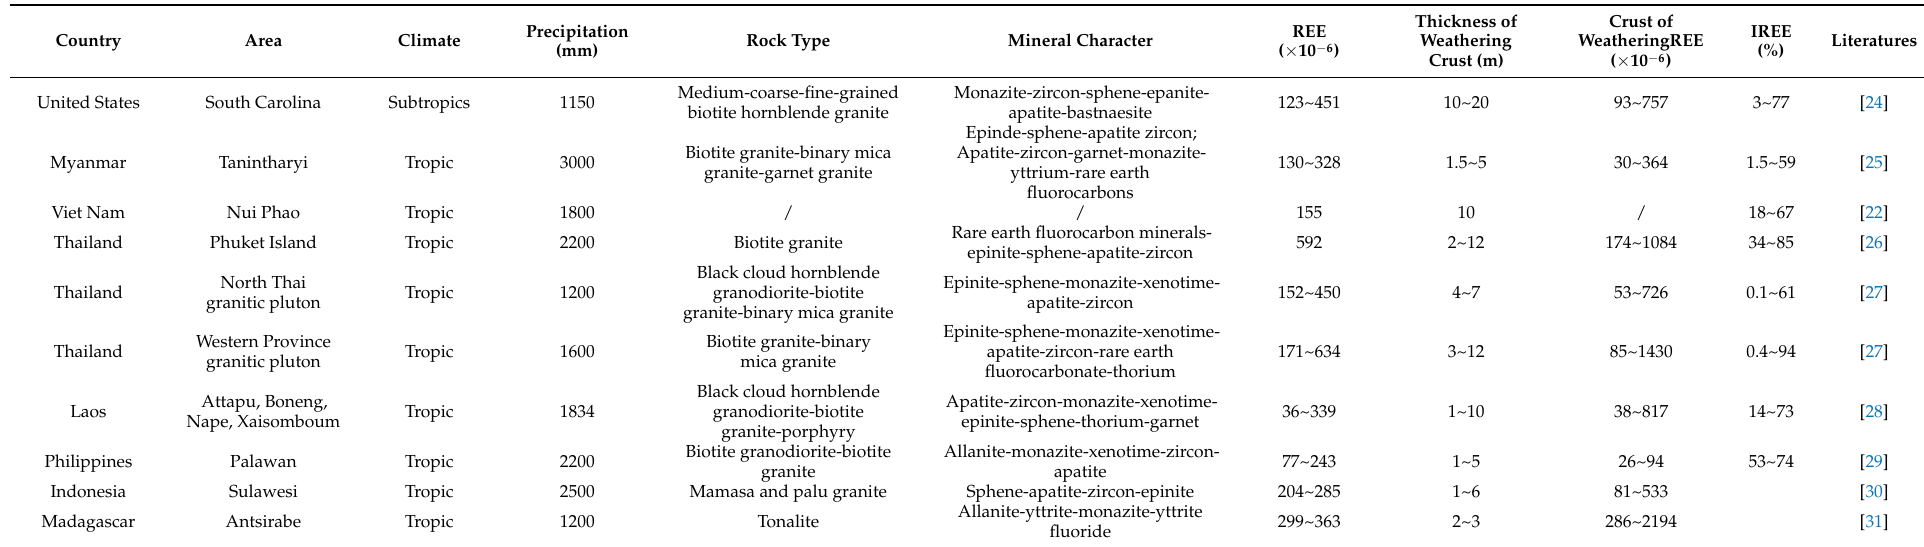
Table 1. Information of ionic rare earth deposits in various